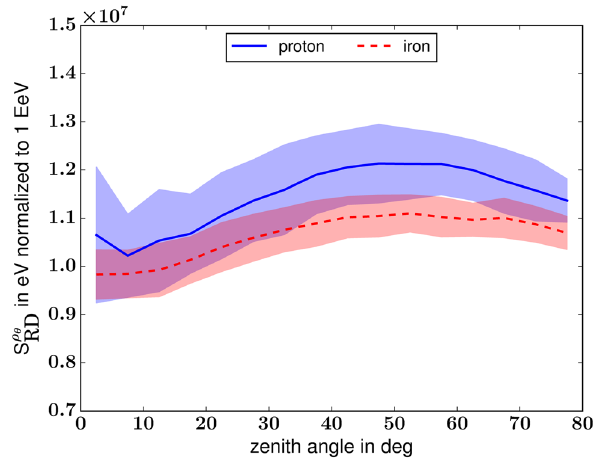
Fig. 7 True radiation energy compared to the zenith angle. The radi- ation energy is corrected for the angle between the geomagnetic field and the shower axis as well as for the air density at the mean X max at the corresponding zenith angle. Furthermore, the radiation energy is cal- culated for the observation level of 1552 m a.s.l. The radiation energy increases with the zenith angle up to 50 ◦ , whereas this effect is larger for proton showers. This leads to an enhanced mass sensitivity at this zenith